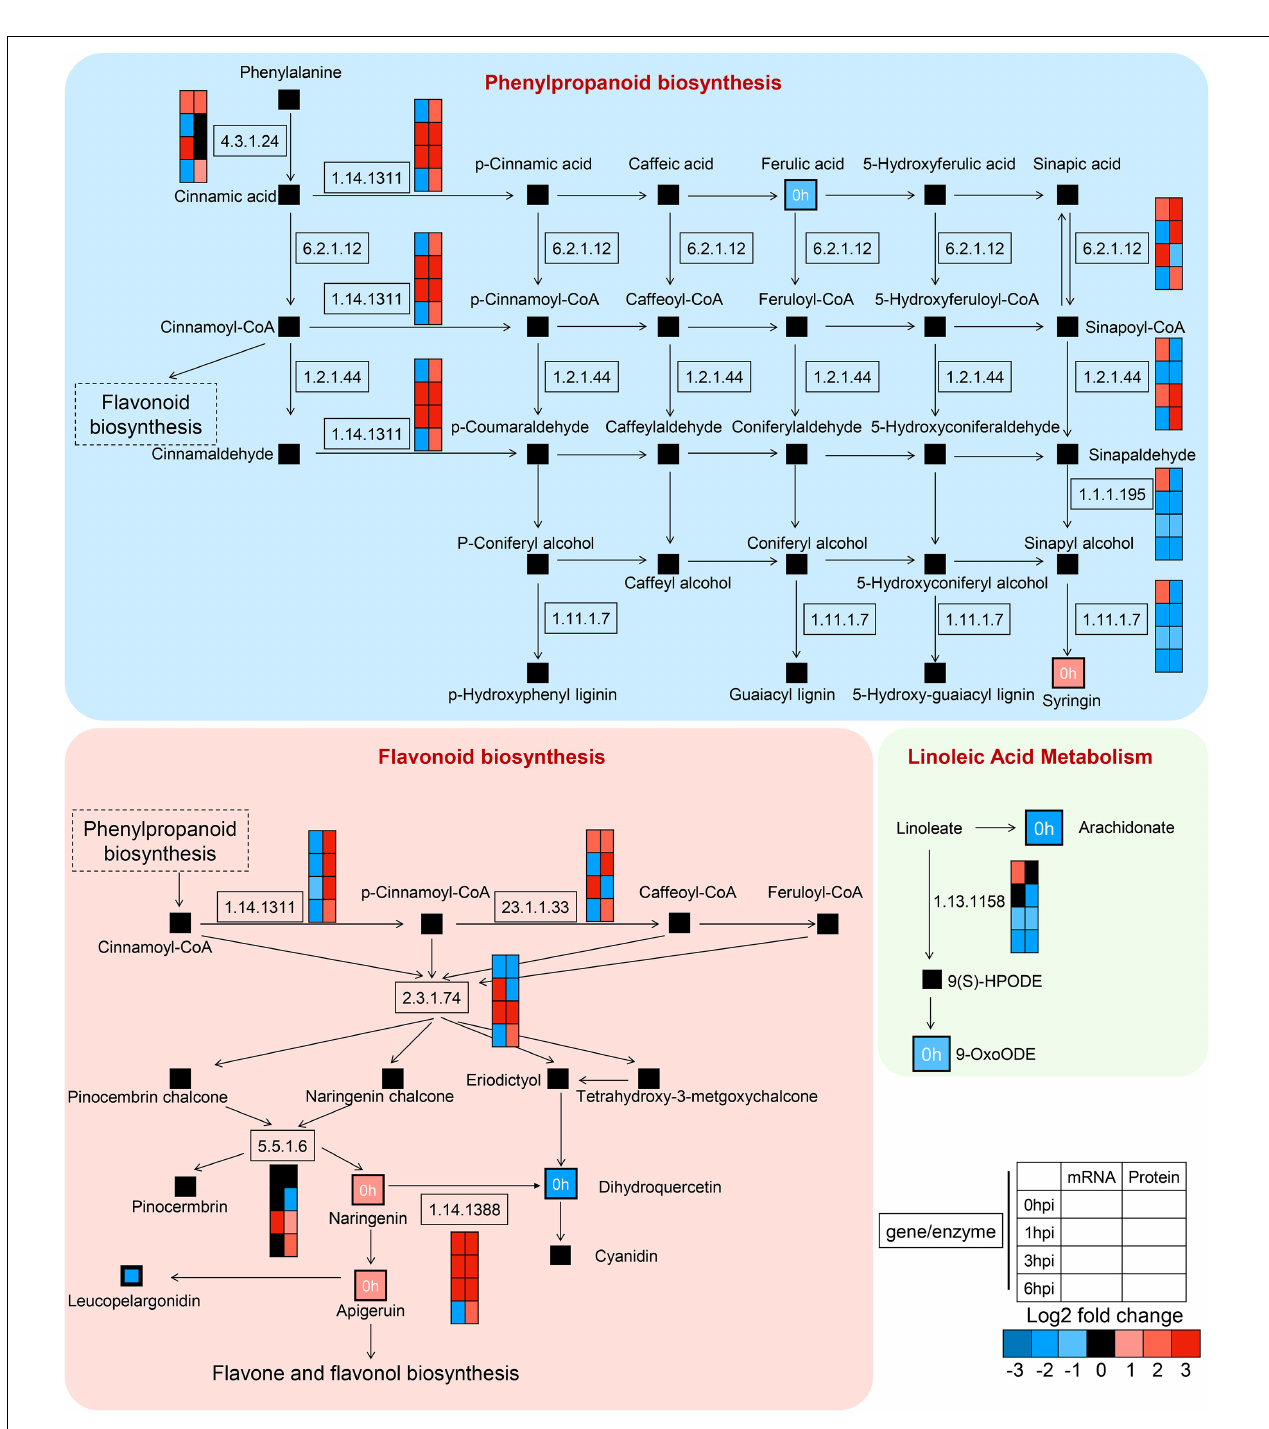
FIGURE 10 | High-resolution mapping of the regulatory network to metabolic pathways. Simplified metabolic flow schemes described changes in metabolites and enriched enzymes associated with transcripts, proteins, phenylpropanoid biosynthesis, flavonoid biosynthesis, and linoleic acid metabolism. The colors indicated rates of upregulation or downregulation of groups of